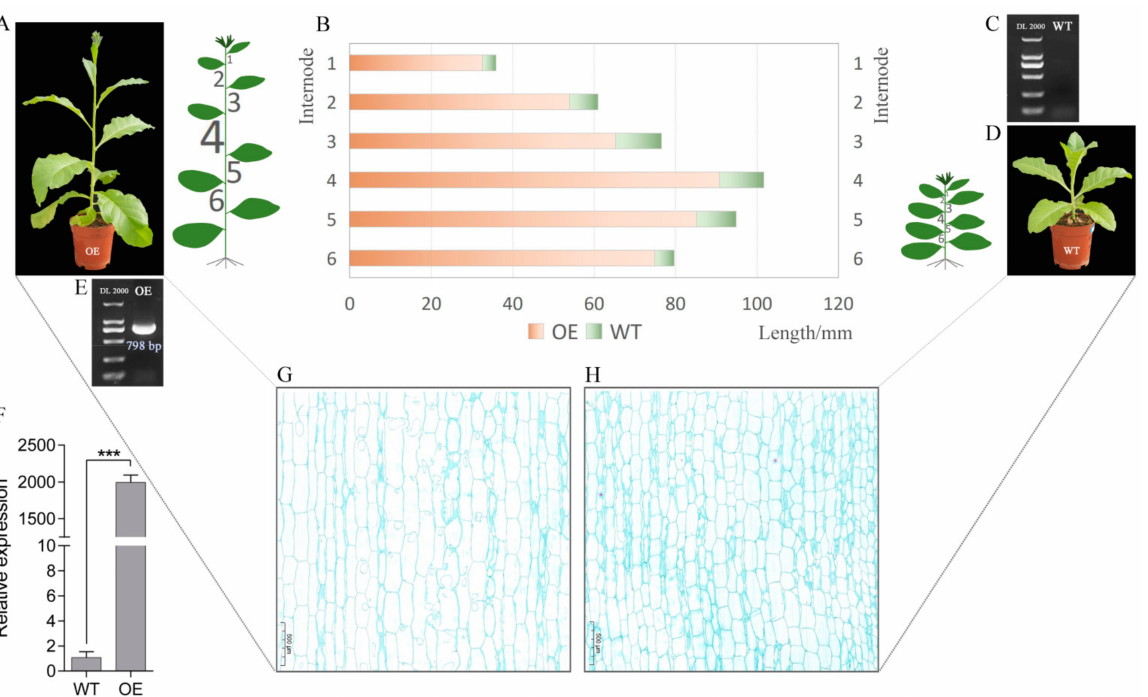
Figure 1. Analysis for internode length of transgenic and wild-type tobacco plants. ( A ) The pheno- types of transgenic tobacco SR1 overexpressing AaMYBC1 . ( B ) Length of six internodes. The yellow and green bar charts represent OE and WT tobacco plants, respectively. The length was measured in millimeters. ( C ) PCR detection of WT tobacco. ( D ) The phenotype of wide typed tobacco SR1. ( E ) PCR detection of OE tobacco plants. ( F ) The expression level of AaMYBC1 in OE and WT tobacco plants. The tobacco actin gene was used as internal control during the RT-qPCR experiment. Values are represented as ± SD of three biological replicates. The mean difference was declared significant at p < 0.001 and presented as “***”. ( G ) Cytological observation of internode from OE tobacco plants. ( H ) Cytological observation of internode from WT tobacco plants. Scale bars: 500 µ